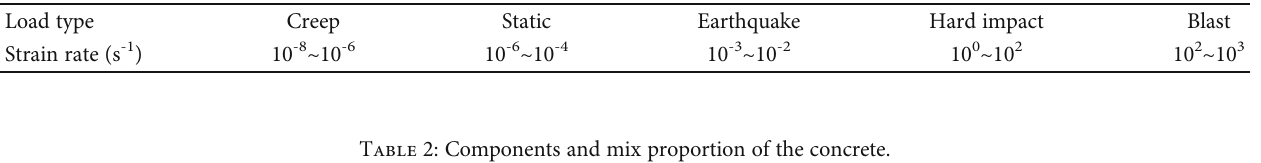
Table 1: Magnitude of strain rates expected for di ff erent loading cases [17].